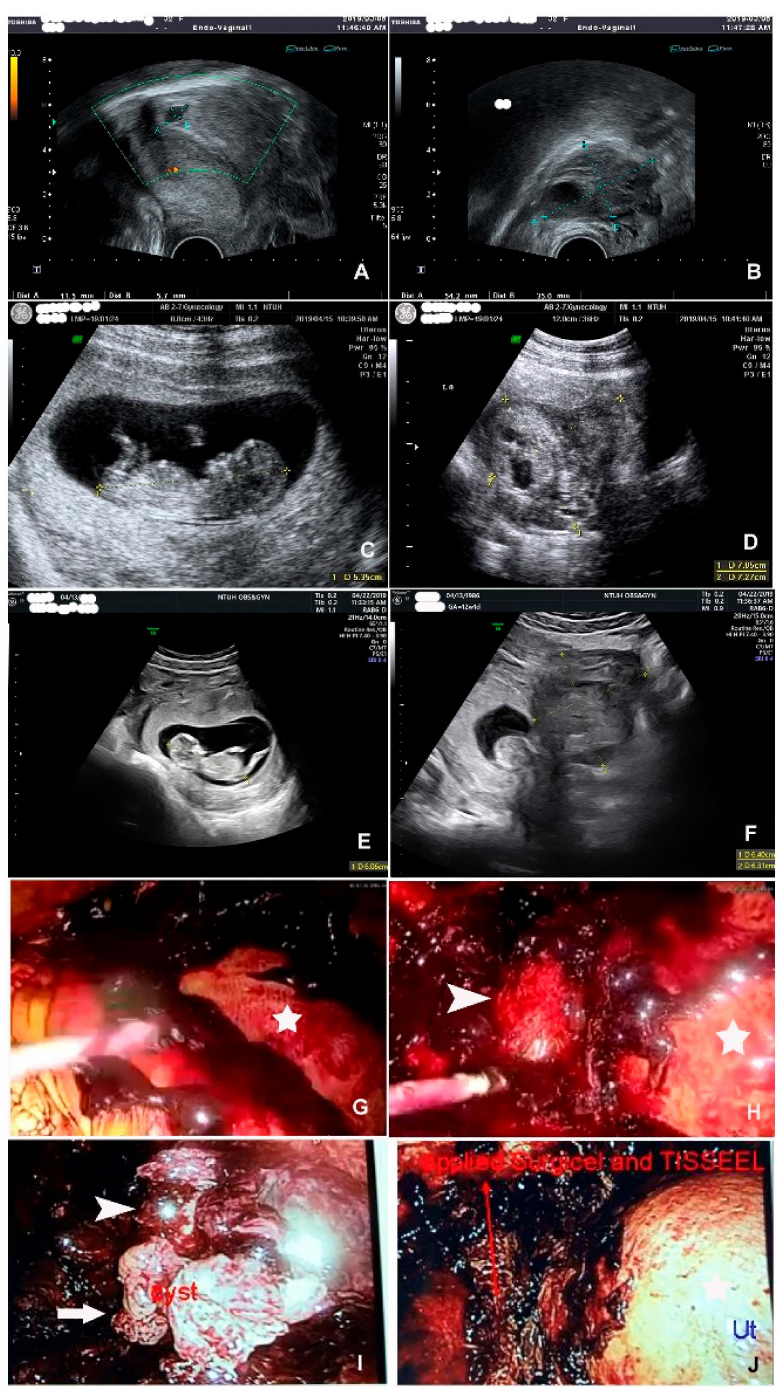
Figure 3. Heterotopic pregnancy. ( A ) Ultrasonography at GA 5 weeks revealing an intrauterine gestational sac. ( B ) Ultrasonography revealing a left ovarian mass sized 5.4 cm. ( C ) Ultrasonography at GA 11 weeks revealing early pregnancy with fetal heartbeat. ( D ) Ultrasonography revealing a left ovarian mass sized 7.3 cm, with a suspicion of teratoma. ( E ) Ultrasonography at GA 12 weeks revealing early pregnancy with fetal heartbeat and normal growth. ( F ) Ultrasonography reveal- ing a left ovarian heterogeneous tumor with moderate ascites and normal intrauterine pregnancy. ( G ) Emergency laparoscopic surgery revealing massive internal bleeding covering the gravid uterus (white star). ( H ) Ruptured tubal mass after blood suction (white arrow head), the gravid uterus (white star). ( I ) White arrow indicates the left tubal fimbria end. ( J ). Surgicel and Tisseel application after operation and hemostasis to stop